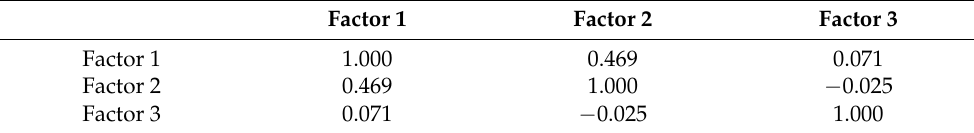
Figure 1. Factor analysis. Factor 2, which is related to dry eye (DE), is plotted against Factor 3, which is related to meibomian gland dysfunction (MGD). Black circles indicate diagnosis of DE or MGD in both eyes. Whites circles indicate age, sex and ocular symptoms. Table 4. Correlation between factors in factor analysis ( n = 308).